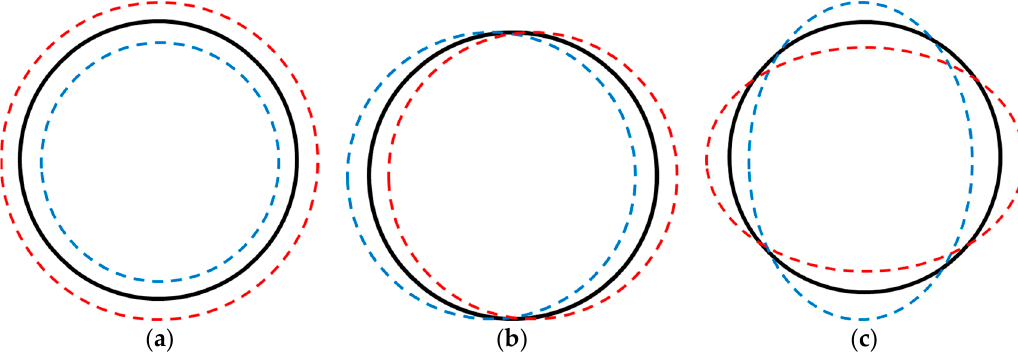
Figure 8. Circular ring mode shapes: ( a ) n = 0 mode; ( b ) n = 1 mode; ( c ) n = 2 mode.